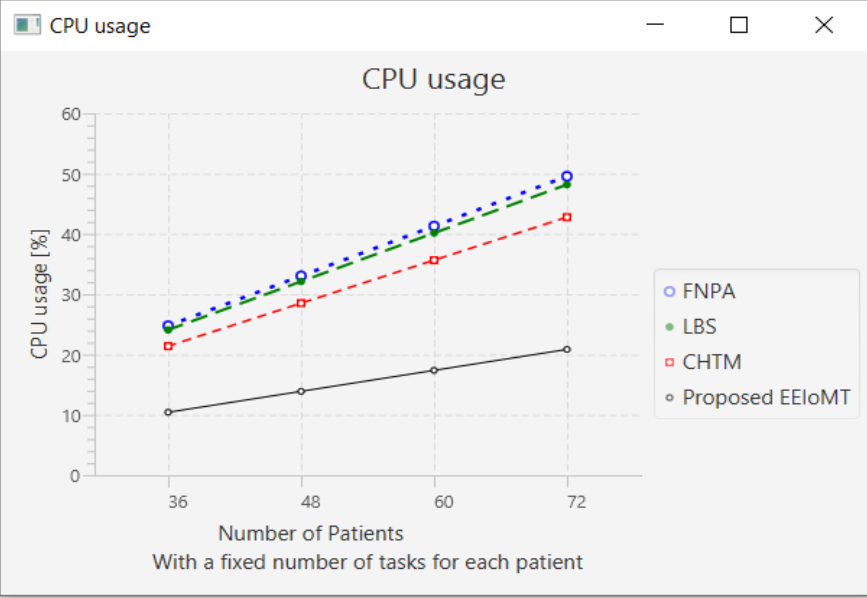
Figure 11. CPU usage comparison when changing the number of patients.